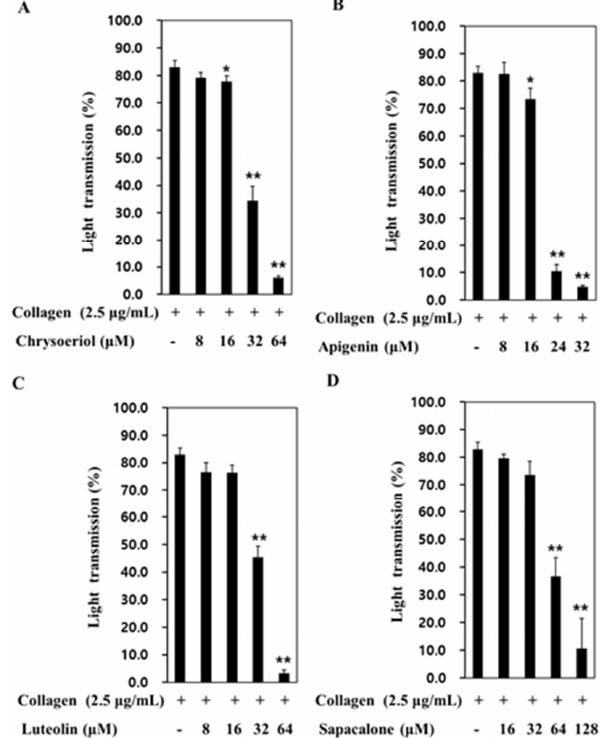
Figure 6. Effects of four key components on agonist-induced platelet aggregation. ( A ) Chrysoeriol. ( B ) Apigenin. ( C ) Luteolin. ( D ) Sappanchalcone. The results are shown as mean ± SD ( n = 4). * p < 0.05, ** p < 0.001 in comparison to the agonist-induced vehicle control.